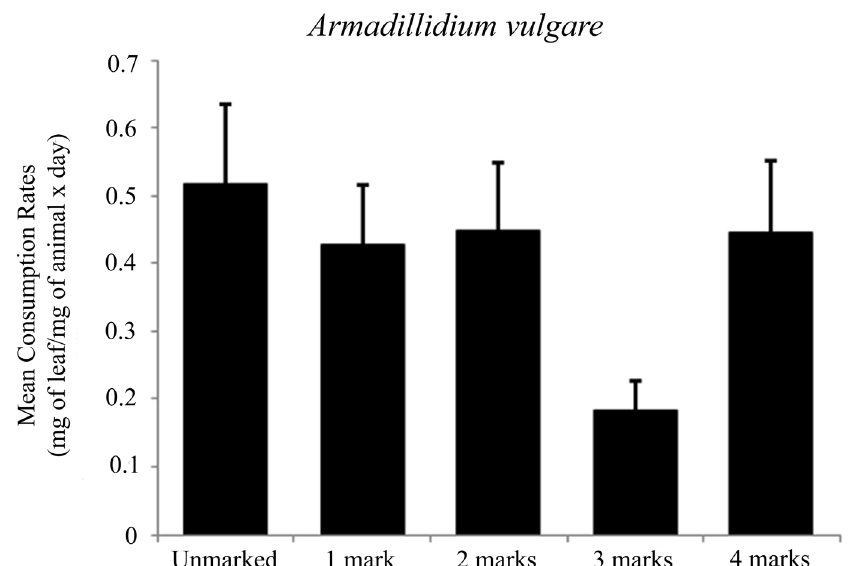
Figure 7. Mean relative consumption of Armadillidium vulgare fed with three leaf disks of M. stipitatum during 10 days of experiment. Each treatment corresponding to the number of nail polish external marks on animals’ cuticle (zero – unmarked, one, two, three and four). Vertical bars indicate standard error.